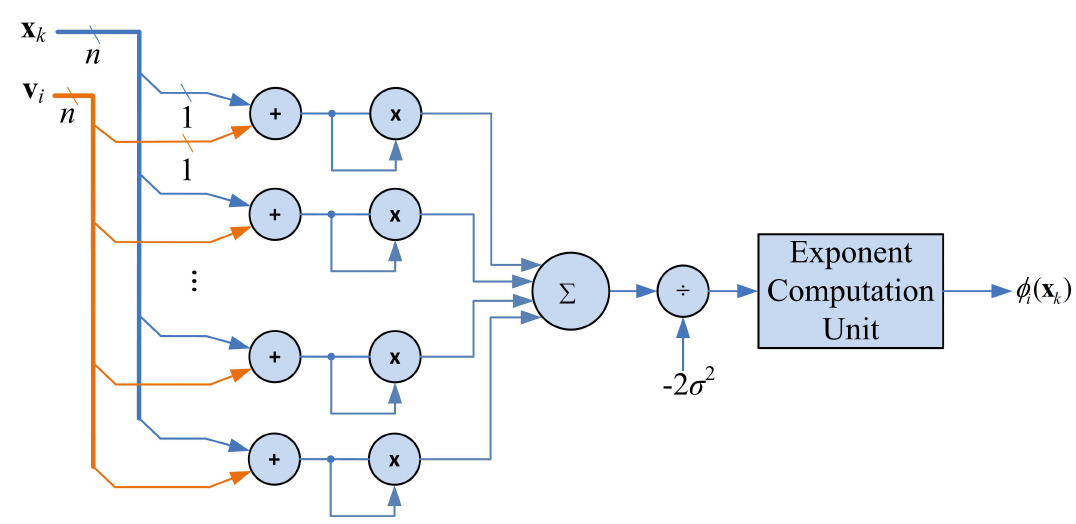
Figure 9. The architecture of kernel Gaussian computation